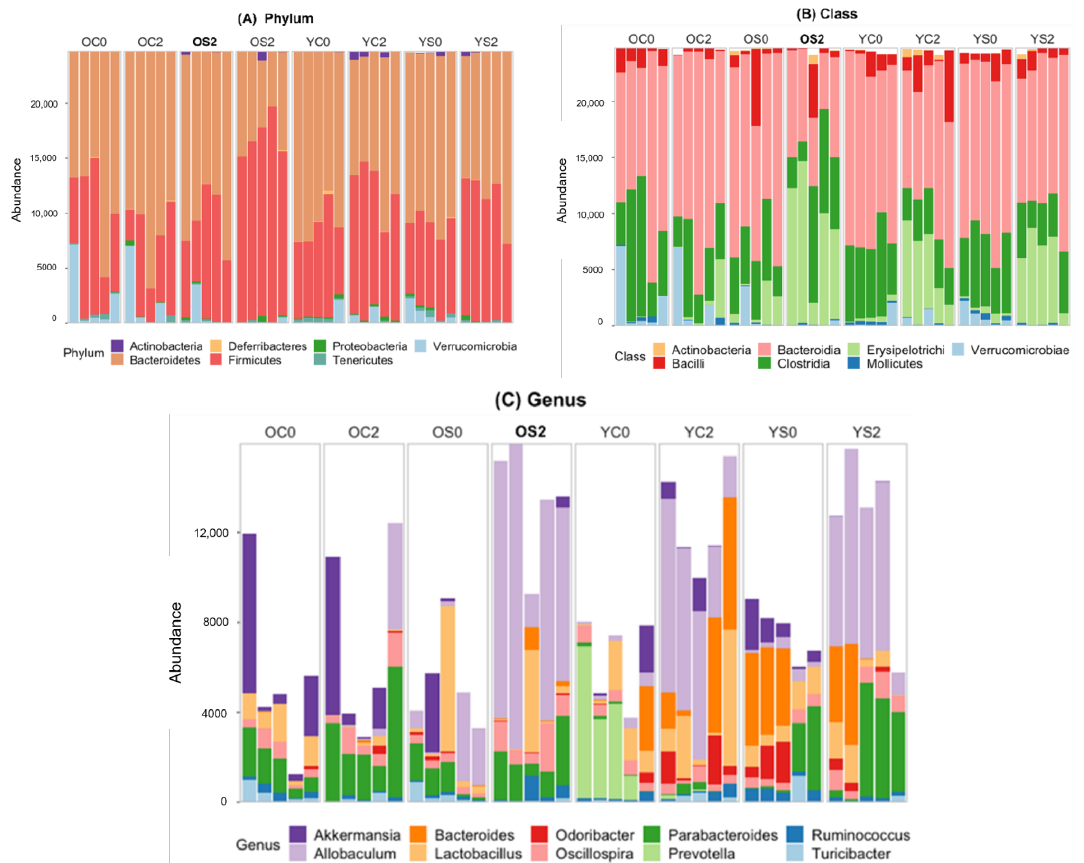
Figure 3. Gut microbial composition ( A ) at the phylum level, ( B ) at the class level, and ( C ) at the genus level. Each bar represents abundance of different kinds of bacteria in gut microbiota of each sample. Group notations are the same as in Figure 1.